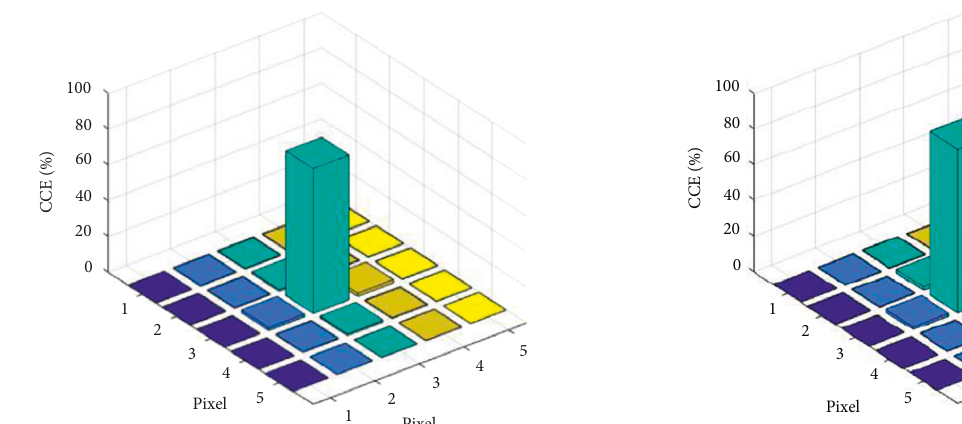
Figure 10: Charge collection efficiency in the 5 × 5 pixel region.